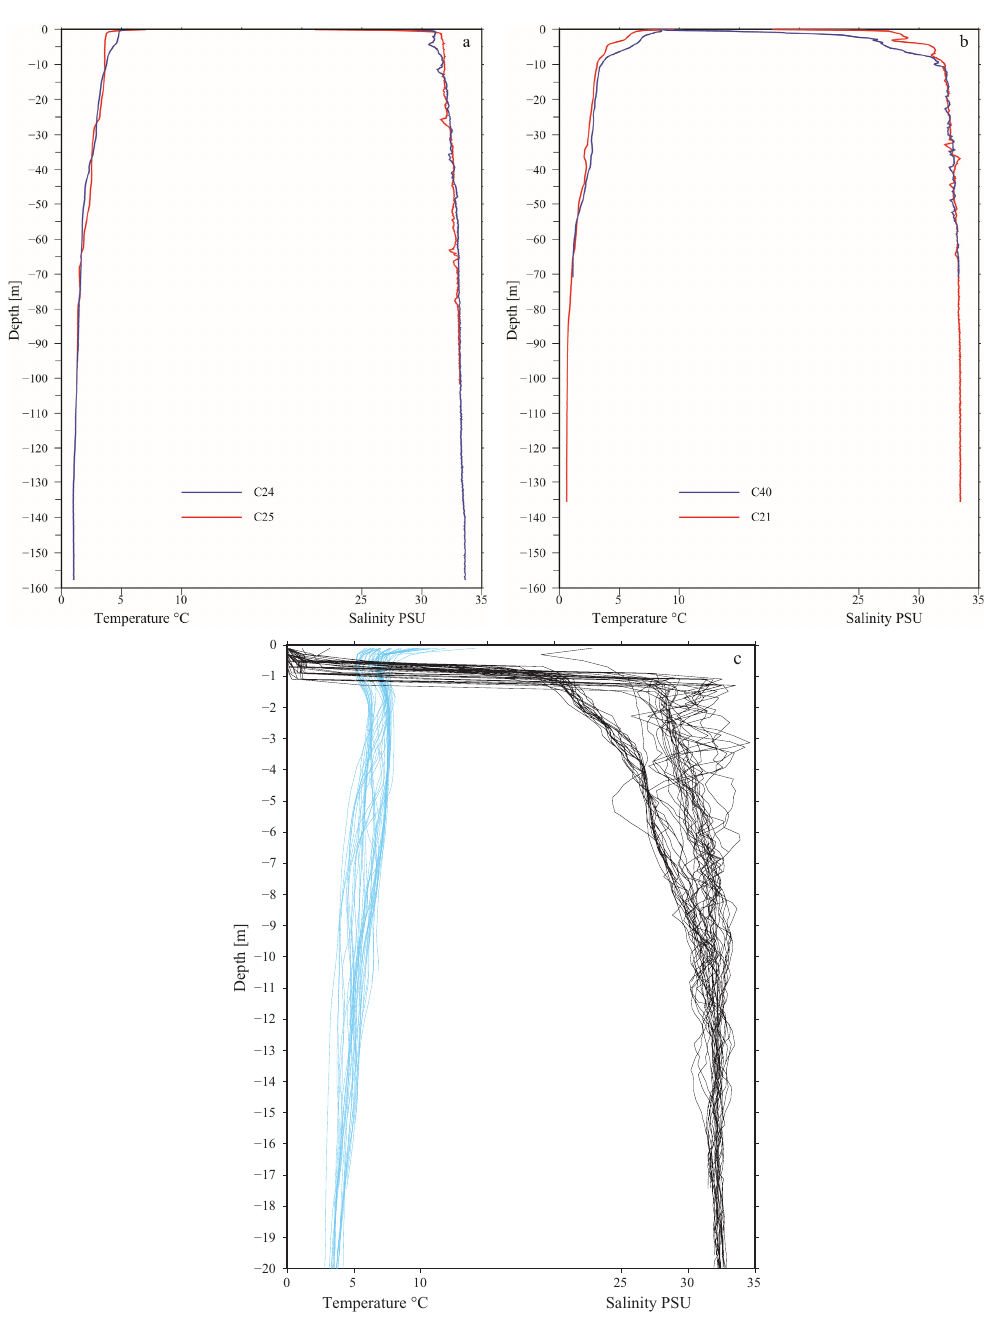
Figure 8. ( a ) CTD profiles (C24 and C25) from south of the Arsuk Island in Figure 1, ( b ) CTD profiles (C21 and C40) in outer Ikka Fjord in Figure 1, and ( c ) all CTD profiles in the inner part of Ikka Fjord with temperatures marked in blue and salinities in